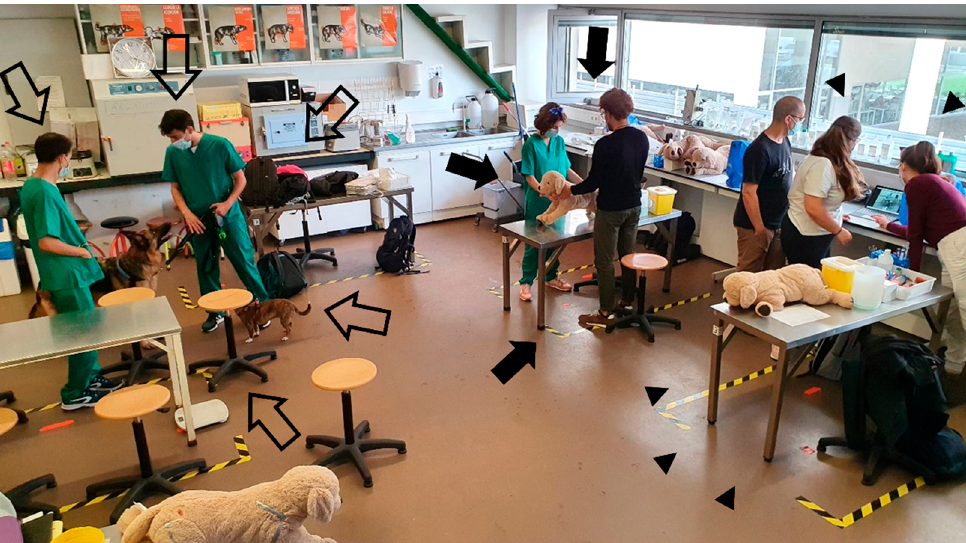
Figure 5. Students practicing out of school time, either using their own animals (block arrows) or stuffed teddy dogs (arrows and arrowheads). The group of students on the right (arrowheads) is also using video resources (supporting class material).